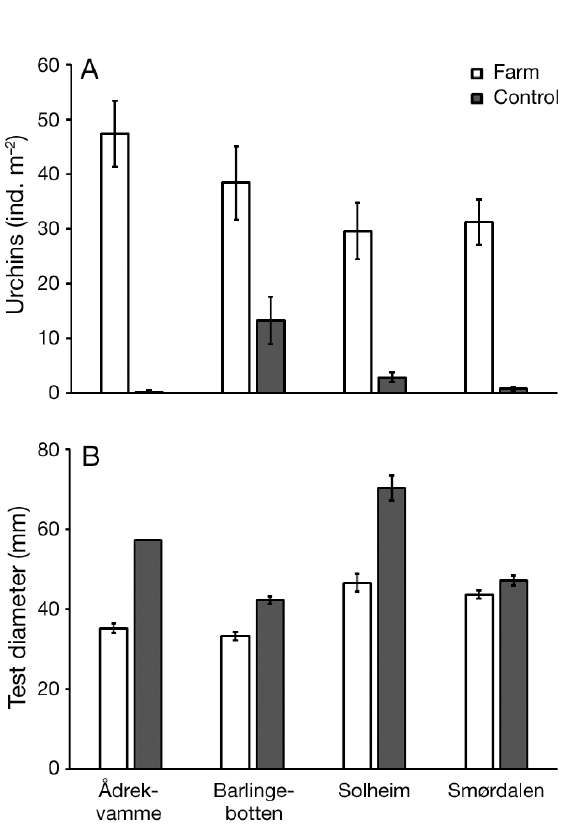
Fig. 1. Results from the field survey of Gracilechinus acutus (A) urchin abundance (m –2 ) and (B) average test size ± SE at control and farm locations across 4 sites in Masfjord, Norway